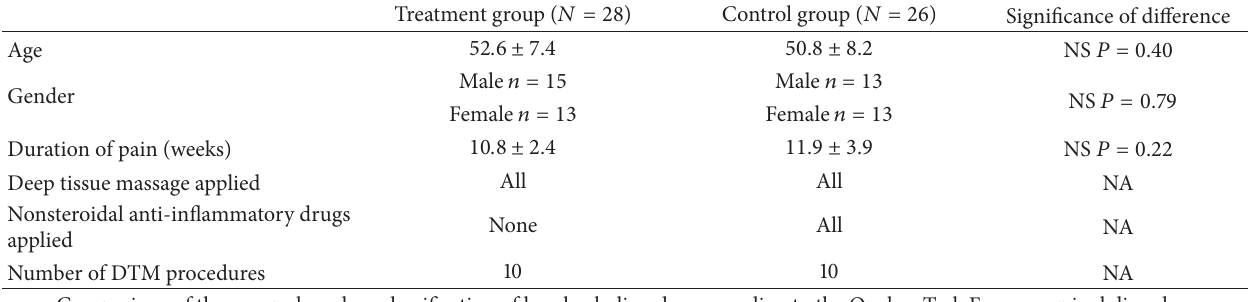
Table 2: Basic characteristics of the